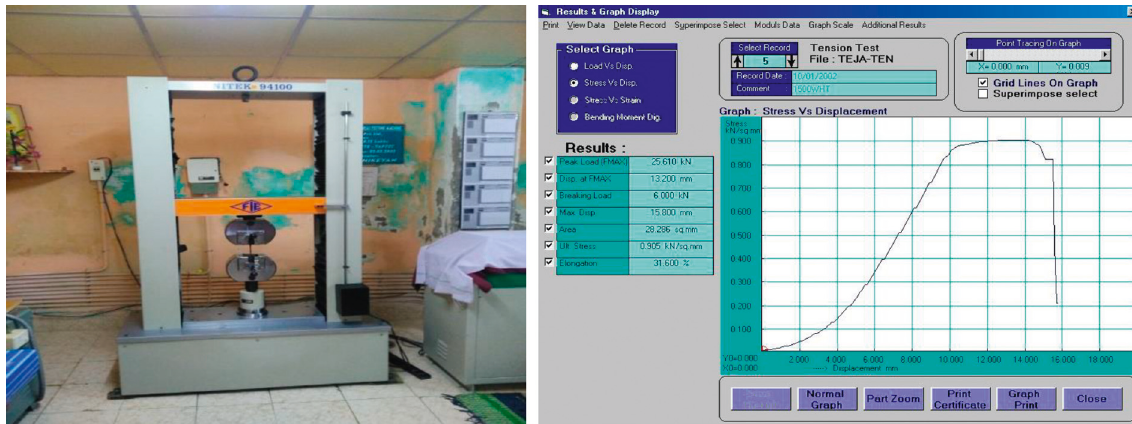
Figure 7: The universal testing machine.